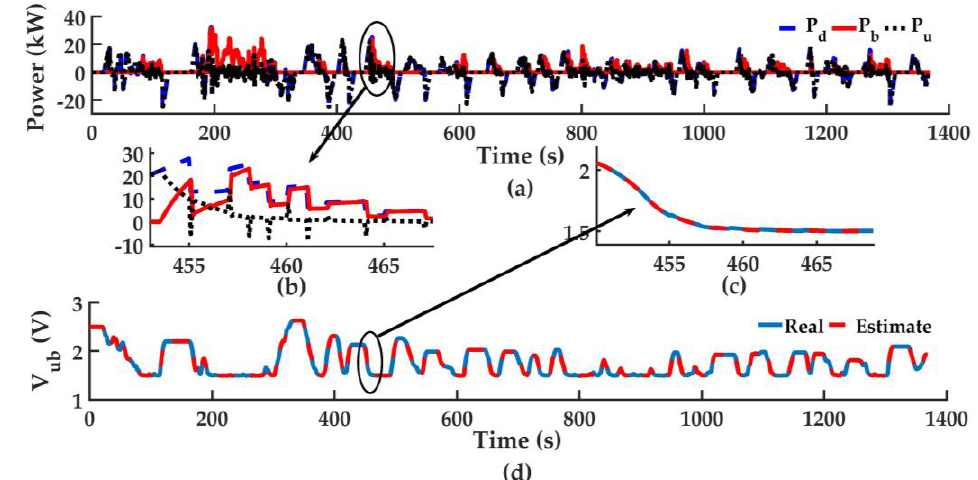
Figure 11. Power distributionof AMPC. ( a ) Power distribution; ( b ) Power distribution between 450 s and 470 s; ( c ) V ub variation between 450 s and 470 s; ( d ) V ub variation.